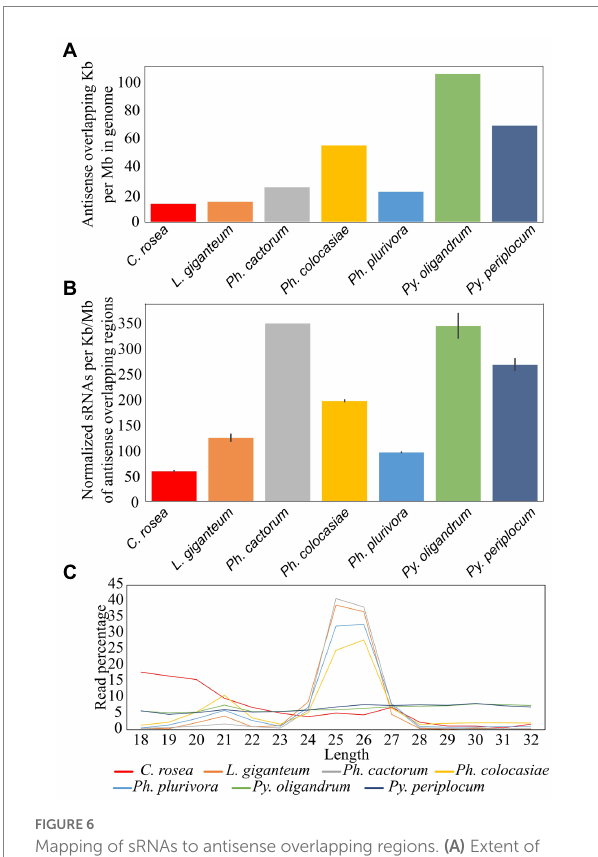
FIGURE 6 Mapping of sRNAs to antisense overlapping regions. (A) Extent of antisense overlapping regions in the analyzed species. (B) Number of sRNA reads mapping to antisense overlapping regions. Data normalized according to millions of reads per sample, length of the genomes and length of the antisense overlapping regions. Error bars indicate the standard deviation. (C) Length distribution of sRNAs mapping to antisense overlapping